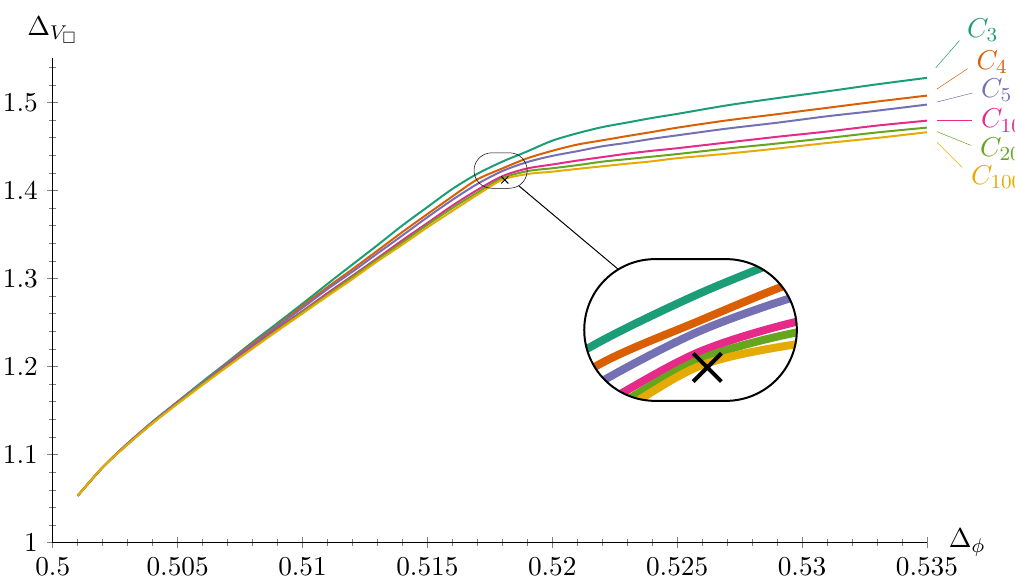
sector of the (cid:30) i (cid:2) (cid:30) j (cid:3)